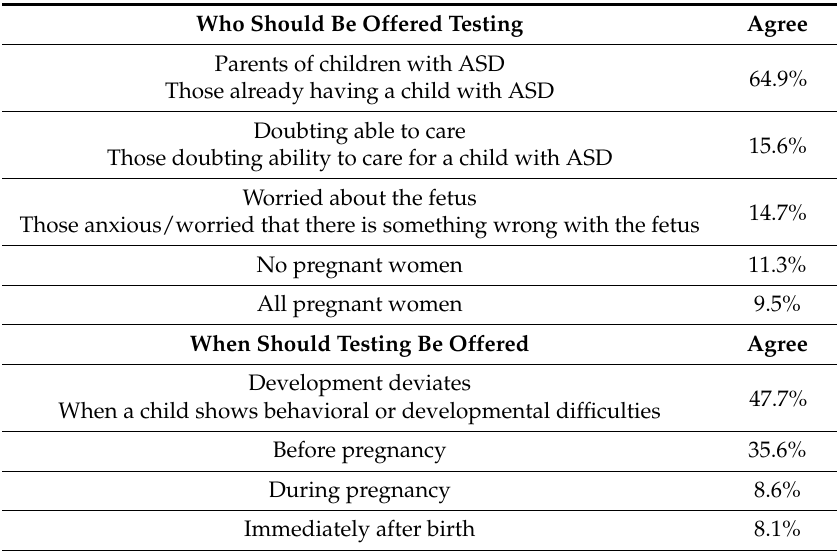
CGT: Clinical genetic testing; ASD: Autism spectrum